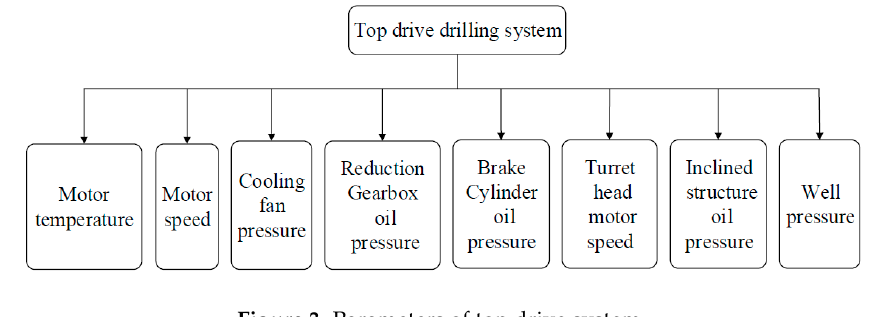
Figure 3. Parameters of top drive system. Table 1. Design parameters of DQ-90 top drive.